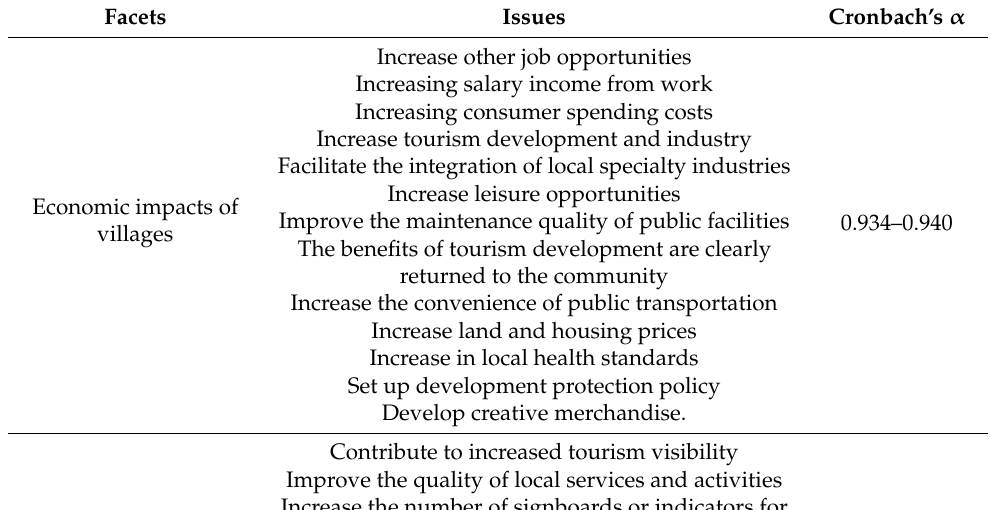
Table 2. Questionnaire for perception analyses of the impact of promoting the keelboat industry on developing coastal areas and the marine